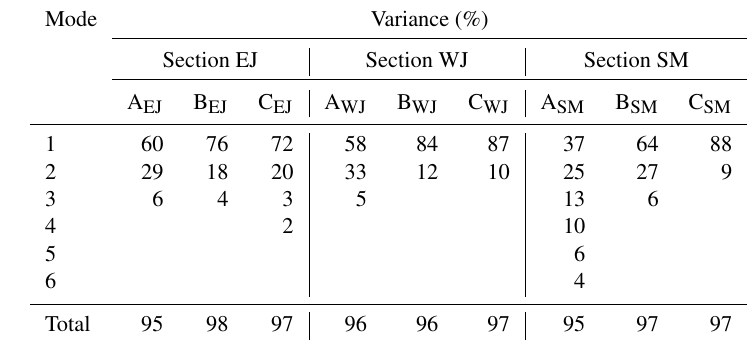
Table 2. Dominant variances at the nine observation points.